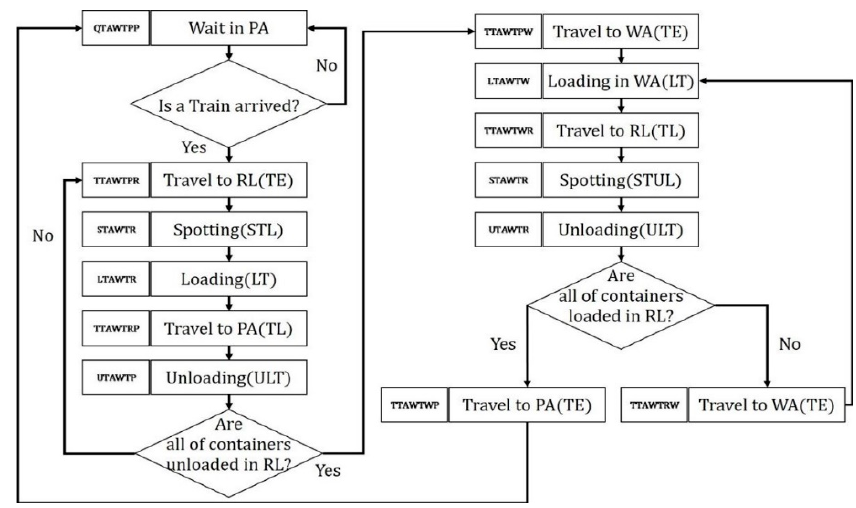
Figure 11. Simulation algorithm for loading/unloading tractor. J. Mar. Sci. Eng. 2020 , 8 , x